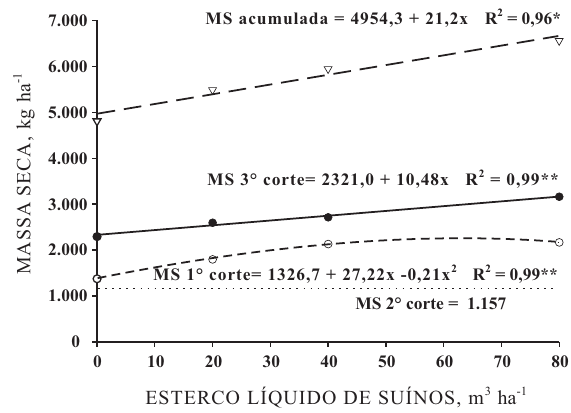
Figura 1. Produção de matéria seca da mistura forrageira de aveia mais azevém, coletada aos 68 (1 o corte), 89 (2 o corte) e 156 (3 o corte) DAE, e massa seca acumulada em função de doses crescentes de esterco líquido de